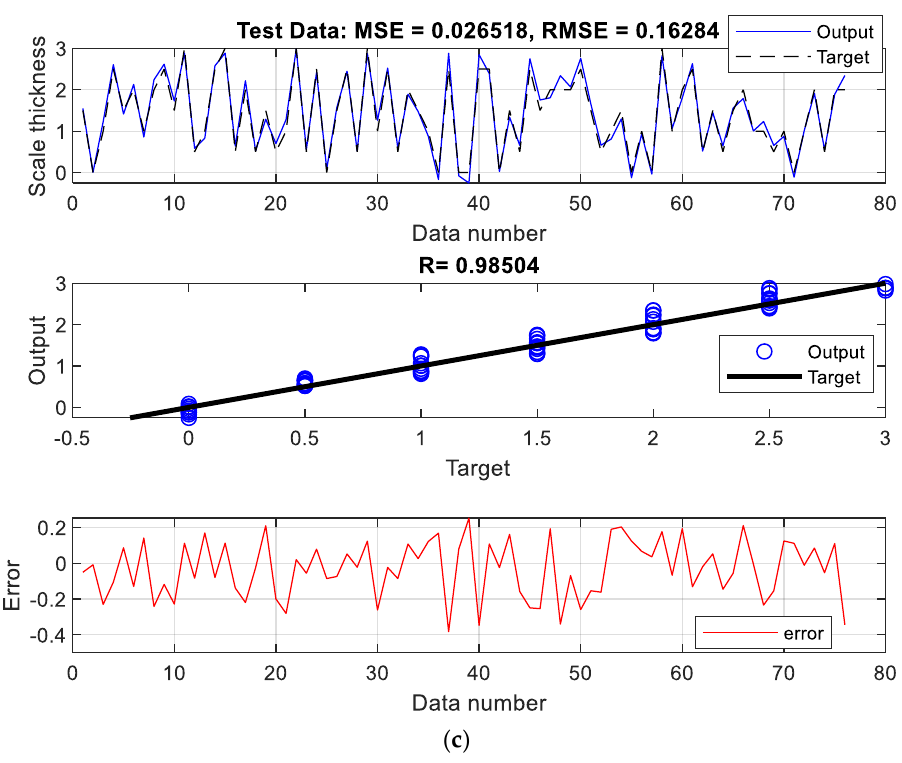
Figure 5. Neural network performance against ( a ) all data, ( b ) training data, ( c ) and test data. Table 1. Comparison of target values with neural network outputs. The symbols “X (Exp)” and “X (Pred)” reflect the experimental and predicted (ANN) values, respectively. N represents the number of data points. The second diagram shows the desired output as a black line and the neural network’s outputs as blue squares.